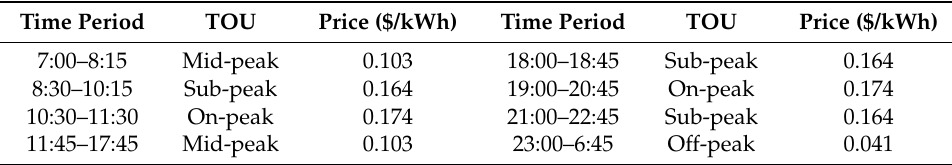
Figure 2. Daily total fixed/inflexible electrical demands of 50 intelligent energy consumers. Table 1. Time-of-use (TOU) electricity prices.